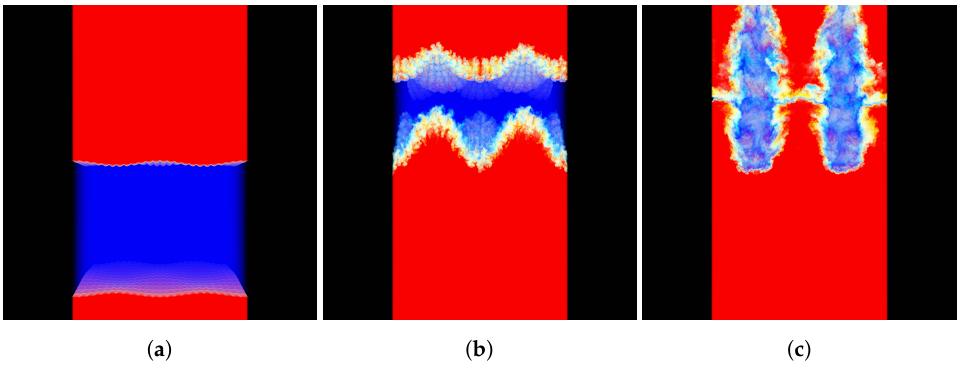
Figure 3. Visualization of the MF data set generated by the RMI simulation at time ( a ) 0 ms, ( b ) 2 ms, and ( c ) 4 ms; blue represents pure air, red represents pure sulfur-hexafluoride (SF 6 ), while yellow represents the binary mixture comprising of the two miscible components.